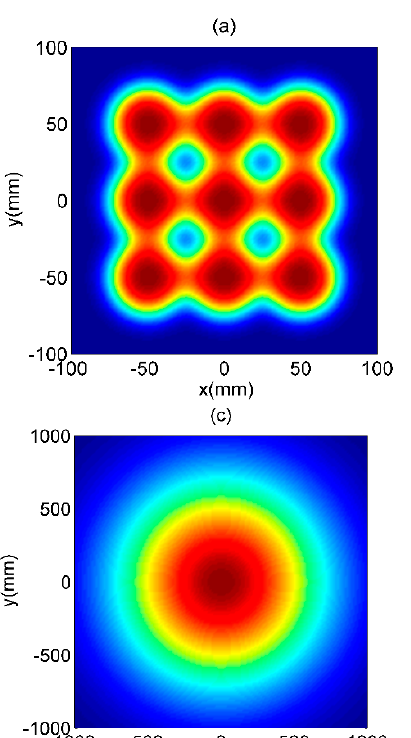
Figure 2. The contour graphs of N D × MGSM array beams propagating through free space with